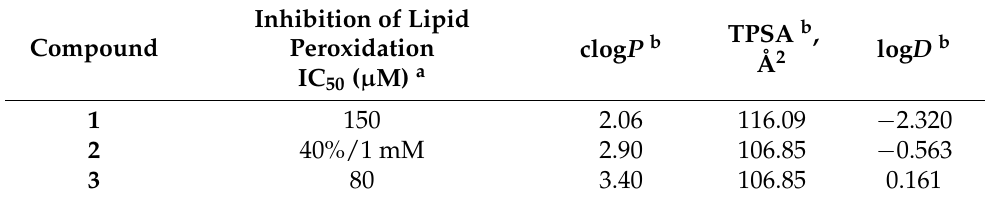
Table 1. Effect of the synthesized compounds on rat microsomal membrane lipid peroxidation.